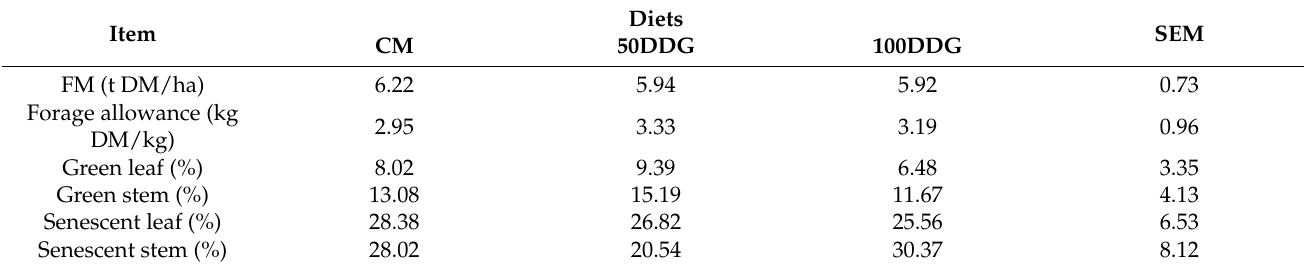
Table 7. Forage mass (FM), morphological fractions and forage allowance of palisade grass in pasture